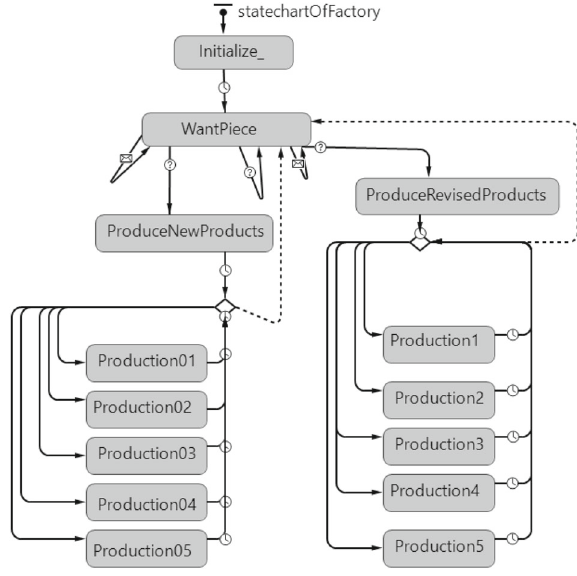
Fig. 6 Statechart of manufacturer